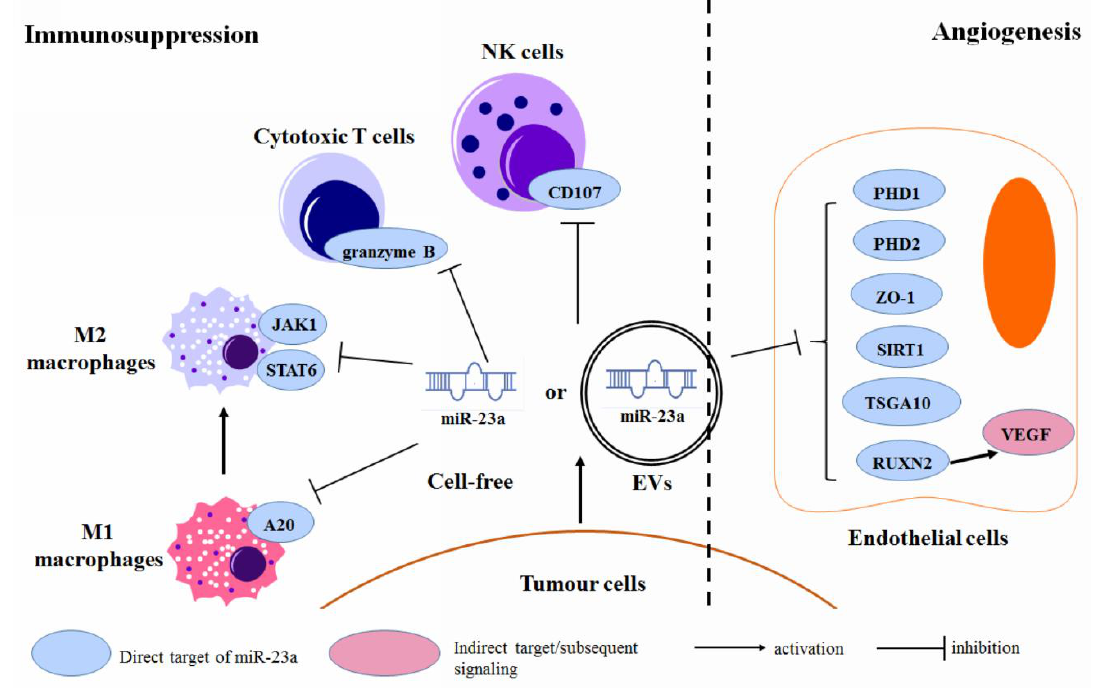
Figure 6. Regulation of the miR-23a on the microenvironment of human cancer.